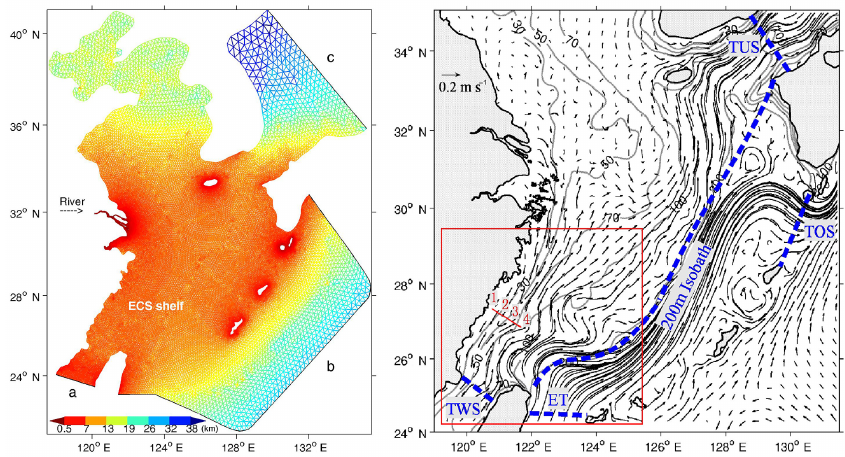
Figure 2. The FVCOM model grid (left panel) and the surface mean flow in the ECS in winter (right panel). The colors in the left panel show the grid length (km). The letters a–c indicate the three open boundaries at the Taiwan Strait, the northwest Pacific Ocean and the Japan/East Sea, respectively. The blue dashed lines (right panel) show some important straits around shelf boundary, including the Taiwan Strait (TWS), the East Taiwan Channel (ET), the Tsushima Strait (TUS), the Tokara Strait (TOS) and shelf break at the 200m isobath. The red rectangle shows the study area of the wintertime TWC. The four red numbers off the Zhe-Min coast show the four mooring sites observed from 5 January to 28 February